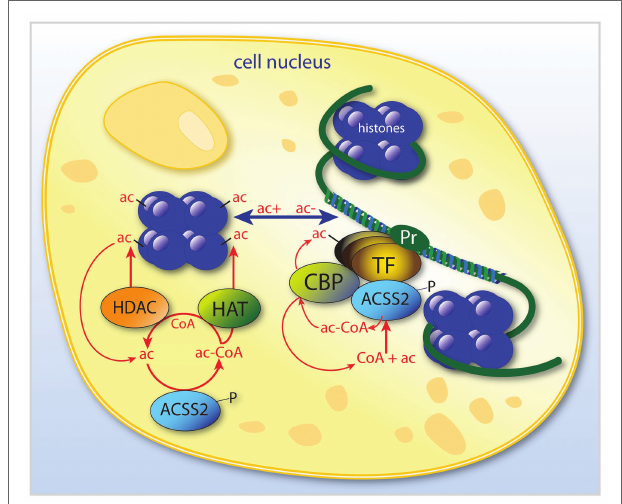
FIGURE 3 | Simplified schematic of the dual roles of ACSS2 in the modulation of transcription in cell nuclei. ACSS2 is involved in the modulation of selective transcription factors by at least two mechanisms. By acting to selectively acetylate (ac) certain histones, ACSS2 facilitates opening of nucleosomes (shown in purple) at specific gene promoter regions (Pr). Further, ACSS2 is also involved in enhancing transcription of those genes via acetylation of transcription factor complexes. ACSS2 acts in the nucleus by additional acetylation mechanisms, for example, many nuclear-localized enzymes are activated or deactivated by ACSS2-facilitated acetylation, including ACSS2 itself, which is inactivated by acetylation. ac, acetate; ac- CoA, acetyl-CoA; ACSS2, acyl-CoA short chain synthetase family member 2; CBP, CREB binding protein; HAT, histone acetyltransferase; HDAC, histone deacetylase; P, phosphorylation site on ACSS2; Pr, gene promoter; and TF, transcription